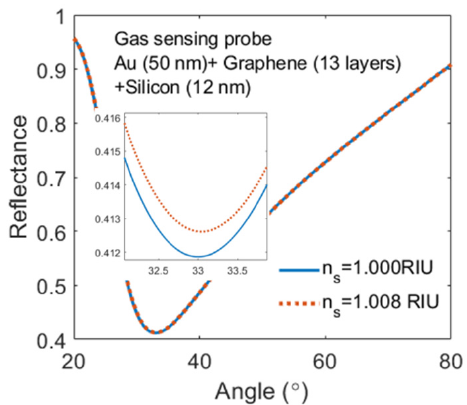
Figure 7. SPR (transmittance) curve for optimized gas-sensing probe with Au (50 nm)/graphene (13 layers)/silicon (12 nm). The inset shows the zoomed-in picture around the SPR dip.